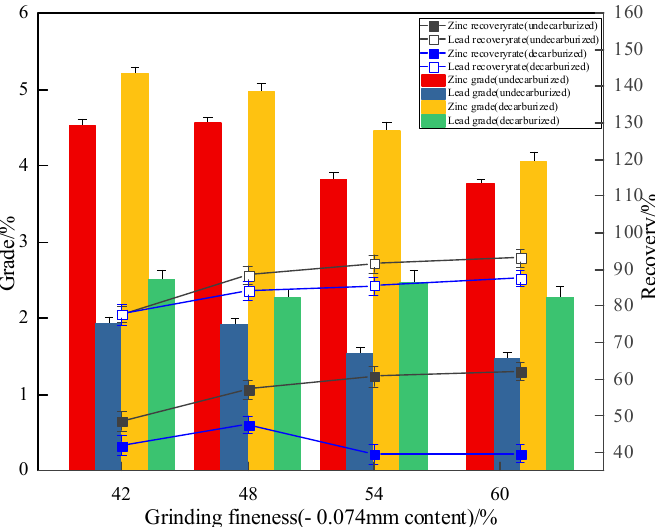
Figure 9. Effect of grinding fineness and carbon on sulfide aggregates.